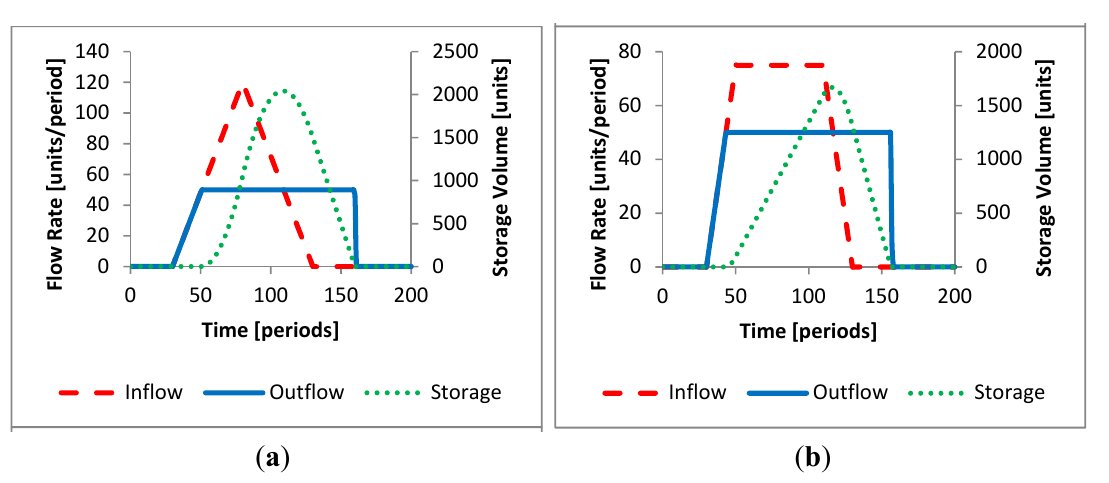
Figure 5. Minimize flood frequency (flooding prevented) for ( a ) Triangular hydrograph and ( b ) Broad peak